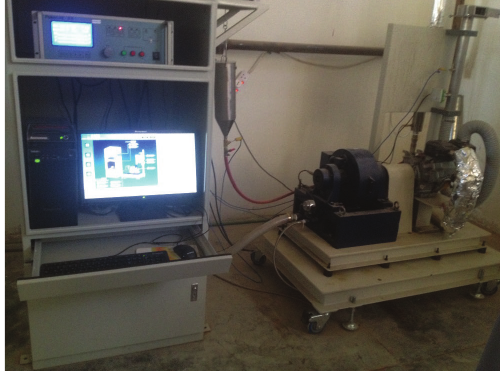
Figure6:SIRobinenginesinglecylinder,aircooledandwithdirect- injection.